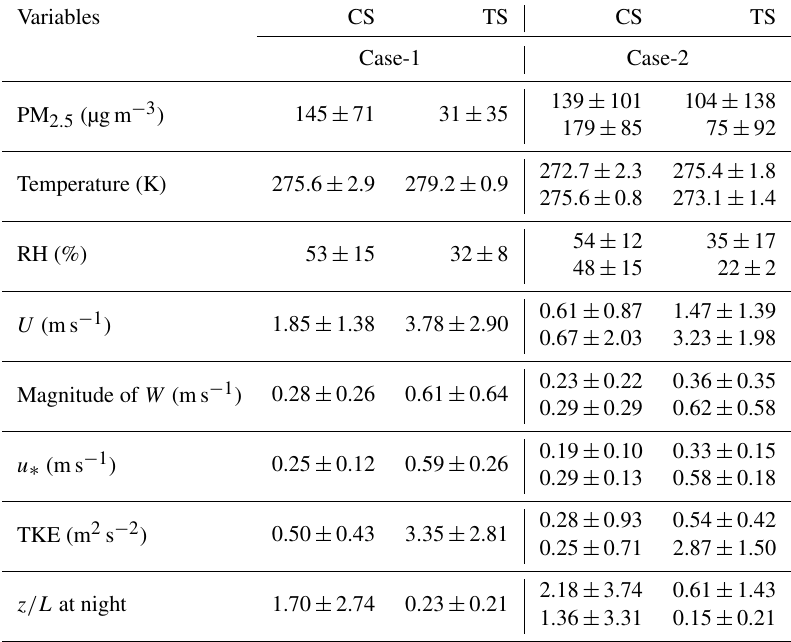
Table 2. Mean and standard deviation (mean ± SD) of key variables during different periods. Variables CS